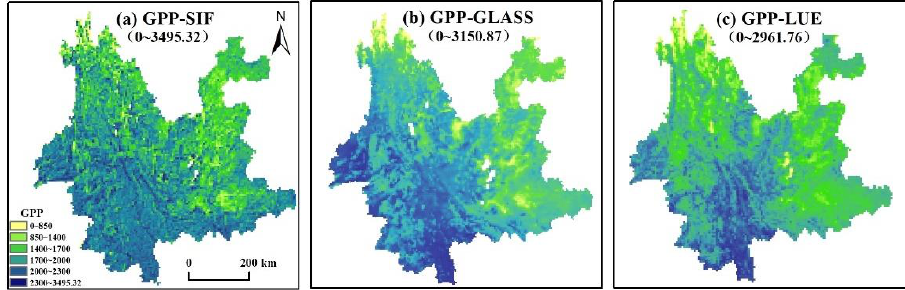
Figure 8. Spatial distribution of GPP SIF data and the other two products data in 2009. ( a ) GPP SIF ; ( b ) GPP GLASS ; ( c ) GPP LUE . (The numbers below the title are the range of values for this raster plot).